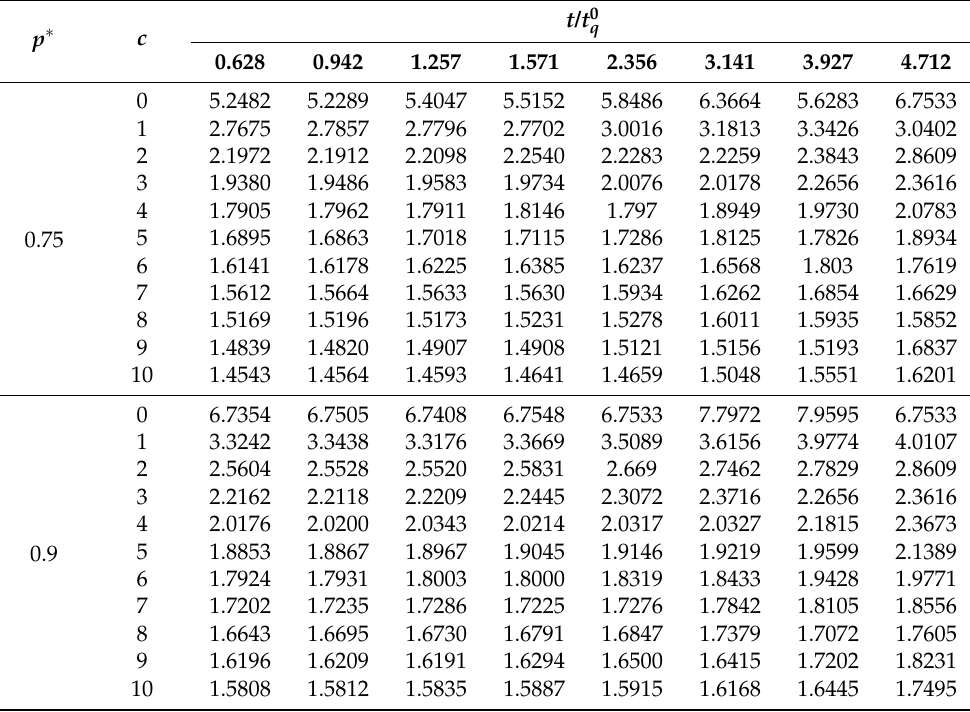
Table 6. Minimum ratio of d 0 for the acceptability of a lot with producer’s risk 0.05 with η = 2 and 0.1 α = 2 for the